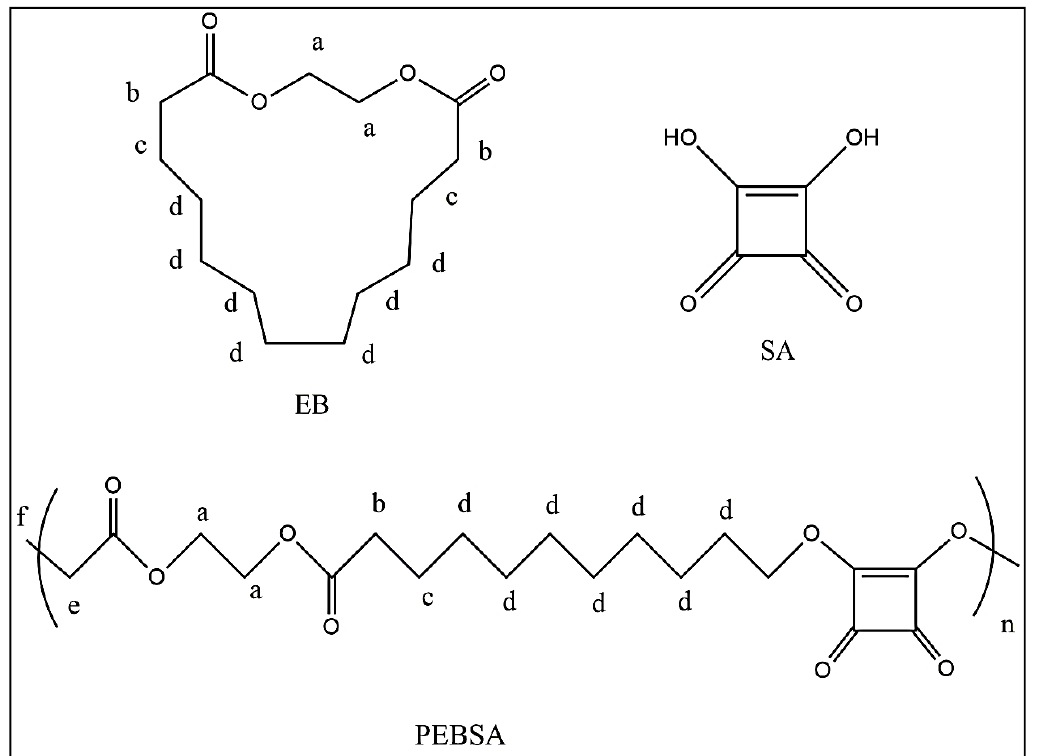
Figure 1. EB, SA and PEBSA assignments in 1 H-NMR spectra.